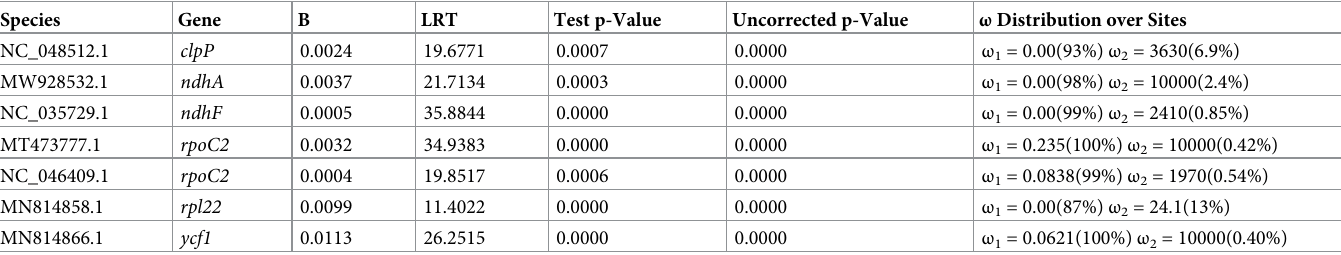
Table 1. The results of positive selection genes at Clerodendrum